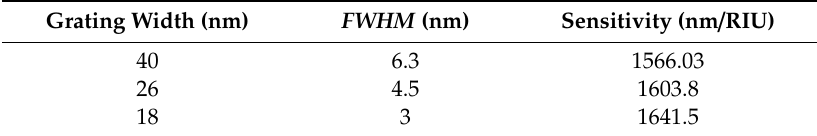
Table 2. Simulated sensitivity and FWHM for di ff erent grating widths (see Figure 1).